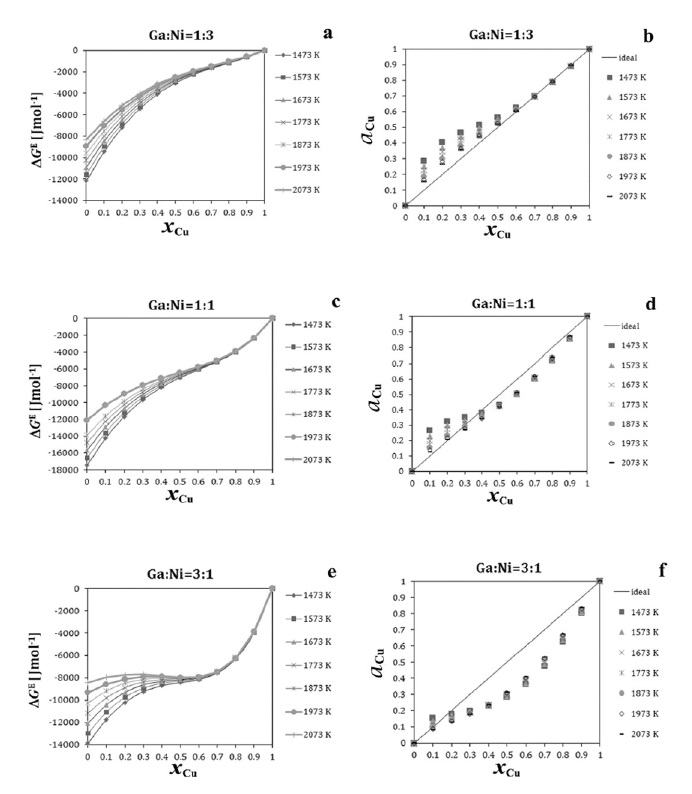
Figure 2: Results of thermodynamic calculation according to GSM in temperature range of 1473-2073K for cross-sections from copper corner: a) integral molar excess Gibbs energy (ΔG E ) and b) copper activity for cross section Ga:Ni=1:3; c) Δ G E and d) copper activity for cross section Ga:Ni=1:1; e) Δ G E and f) copper activity for cross section